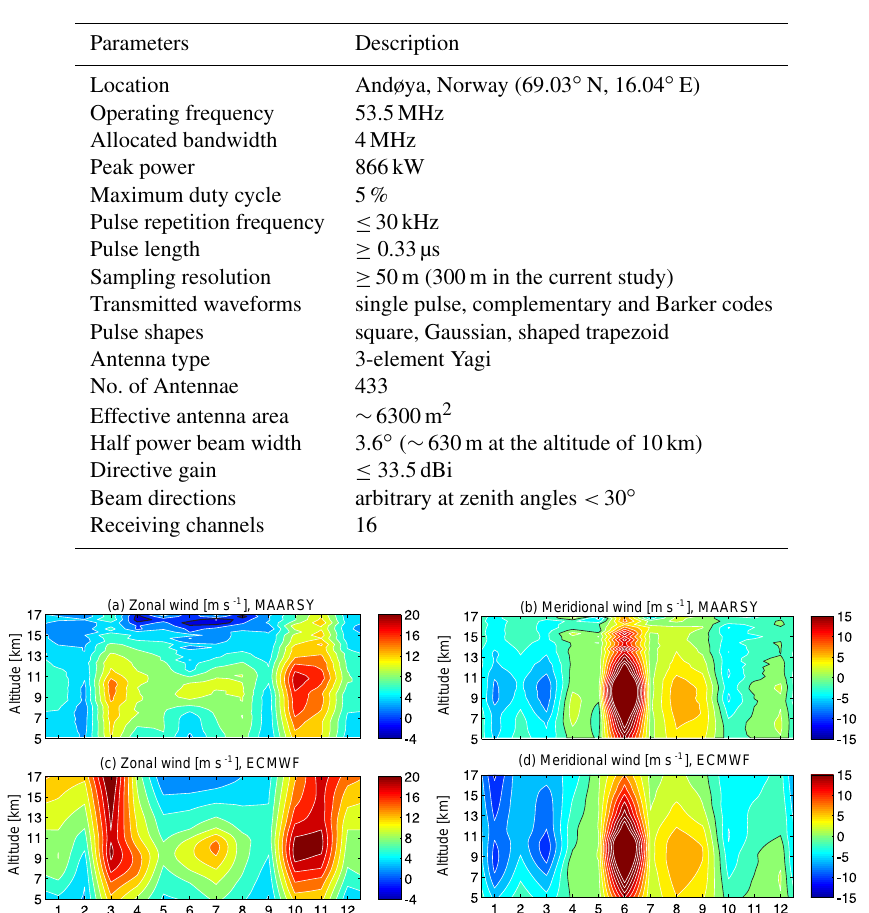
Table 1. Basic parameters of MAARSY.